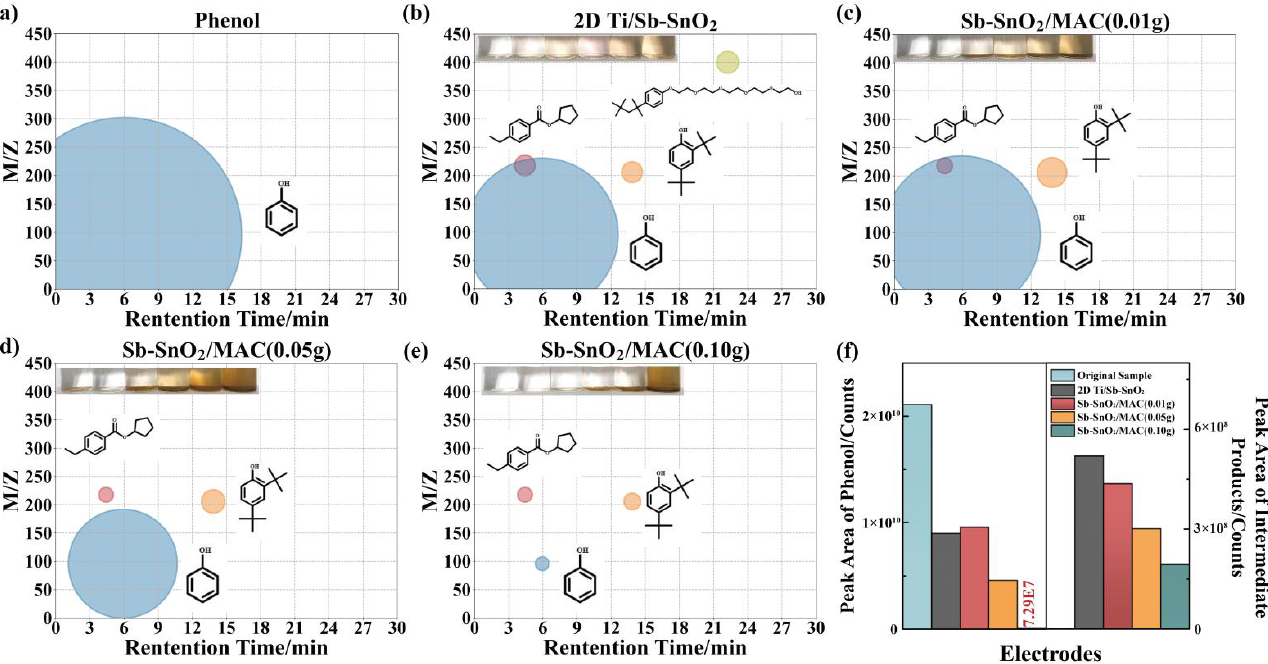
Figure 5. Phenol degradation results under current density of 20 mA · cm − 2 (initial phenol concentra- tion of 100 ppm, anode area of 9 cm 2 , solution volume of 250 mL, supporting electrolyte of 125 ppm of Na 2 SO 4 , room temperature) before and after 3 h electrolysis: ( a – e ) Bubble diagrams of phenol or intermediate products according to their GC peak area (( a ) Original sample of phenol; ( b ) 2D Ti/Sb- SnO 2 (inset: photos of the solution samples); ( c ) Sb-SnO 2 /MAC(0.01 g) (inset: photos of the solution samples); ( d ) Sb-SnO 2 /MAC(0.05 g) (inset: photos of the solution samples); ( e ) Sb-SnO 2 /MAC(0.10 g) (inset: photos of the solution samples)); ( f ) Accumulative GC peak area columns of phenol and intermediate products.